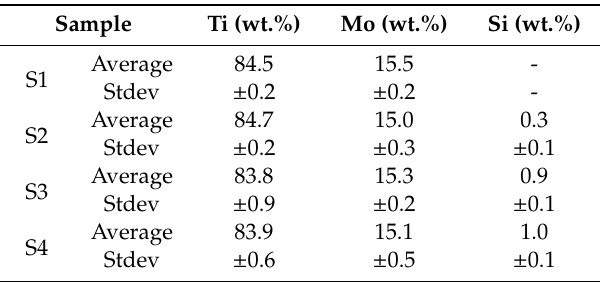
Table 1. Average elemental compositions obtained by energy dispersive X-ray spectroscopy analysis for the base alloy.